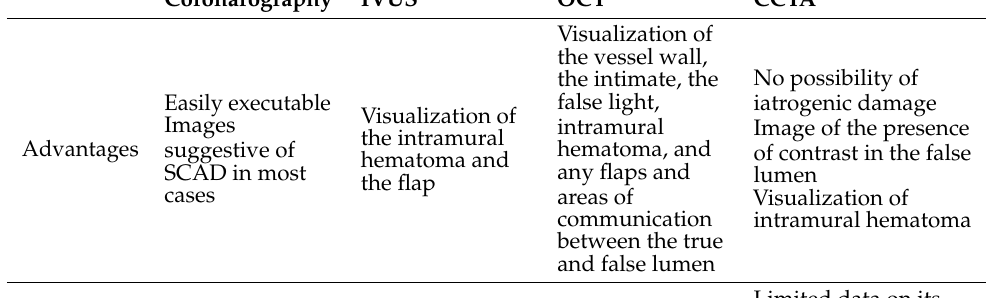
Table 3. Summary of multi-imaging techniques in SCAD adapted from [38].